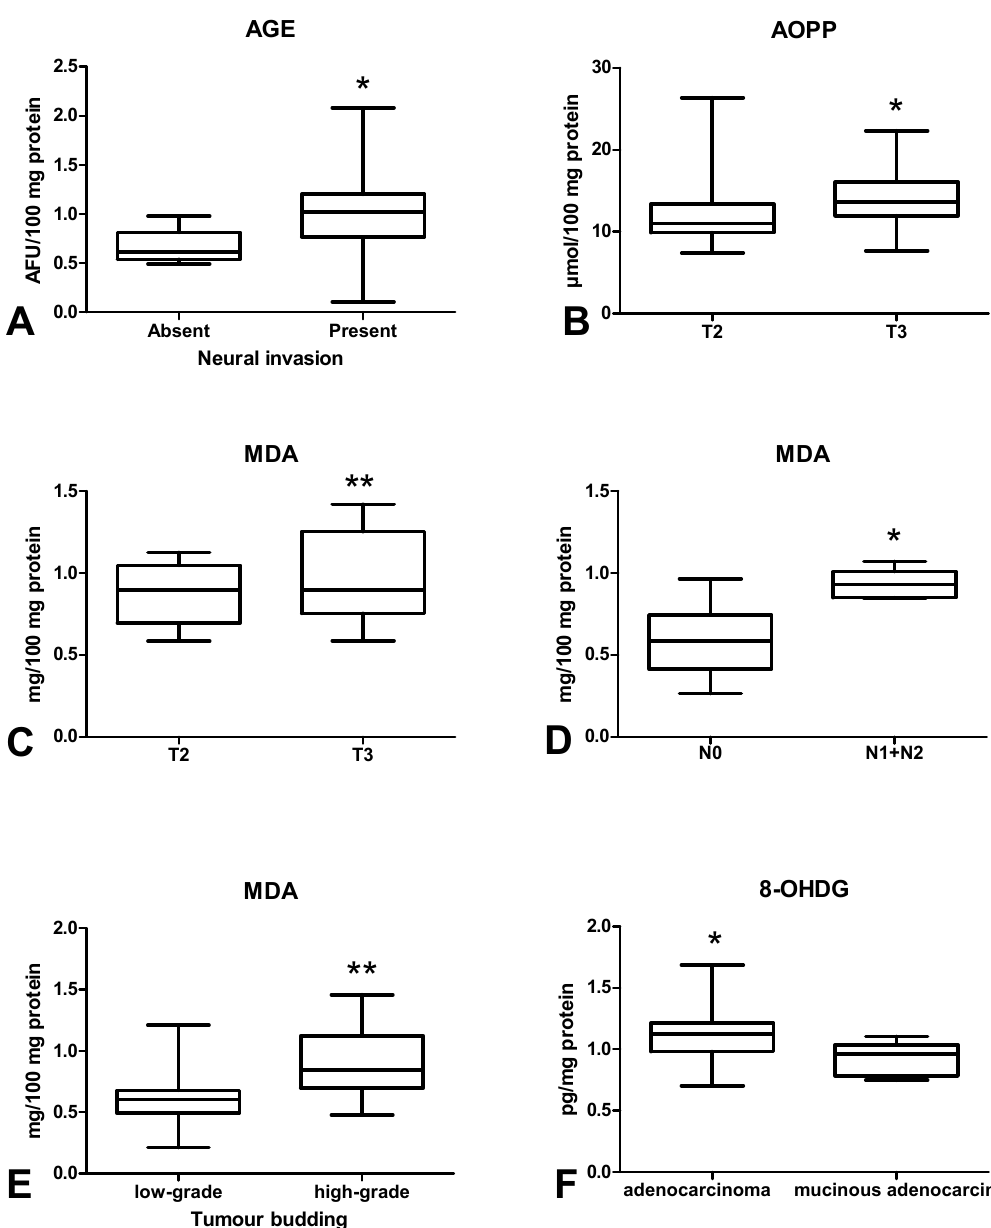
Figure 9. Comparison: of: AGE concentration between colorectal tissue with and without neural invasion ( A ); AOPP ( B ) and MDA ( C ) concentration in colorectal tissue between T2 and T3 stage; MDA concentration between colorectal tissue with and without lymph node metastasis ( D ) as well as between low-grade and high-grade budding ( E ); 8-OHdG concentration ( F ) between adenocarcinoma and mucinous adenocarcinoma. The data are presented as median (minimum–maximum).